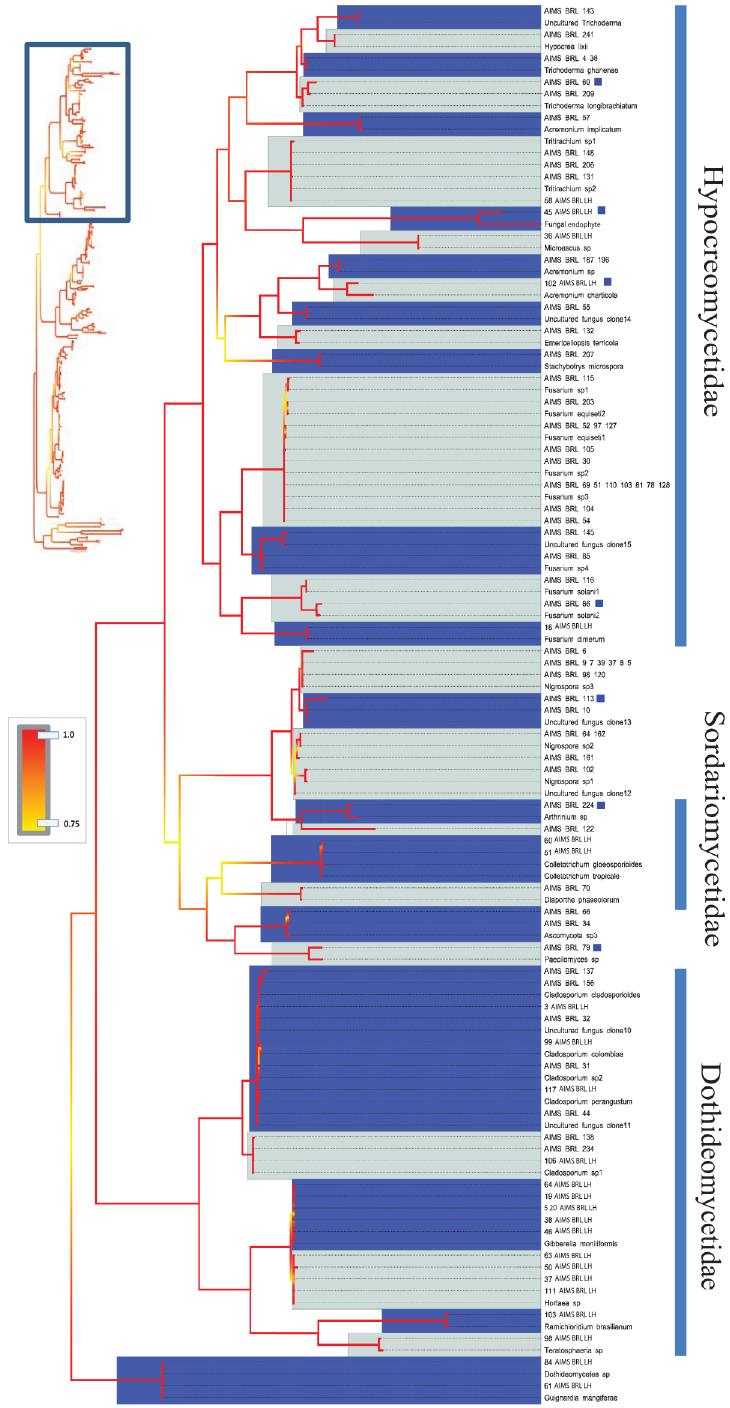
Fig 4. Bayesian phylogenetic hypothesis inferred from ITS barcodes produced in this study and corresponding best BLAST results. Subsection of tree focused on Hypocreomycetidae, Sordariomycetidae and Dothideomycetidae isolates. Alternating dark blue and grey blocks are intended to visually differentiate reciprocally monophyletic OTUs. Yellow-to-red colour gradient denotes posterior probability support throughout the topology. Blue boxes denote unknown